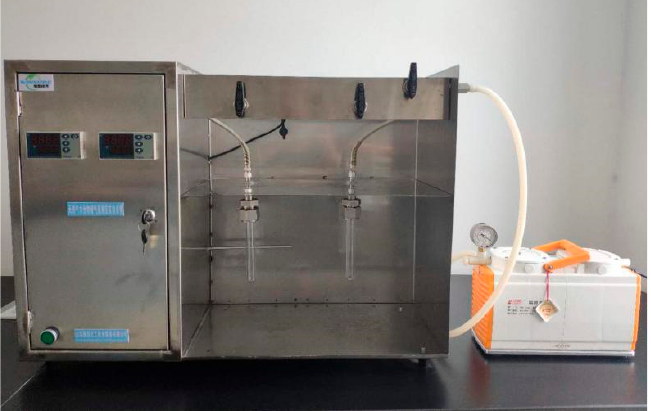
Figure 3. Gas storage capacity measurement device.